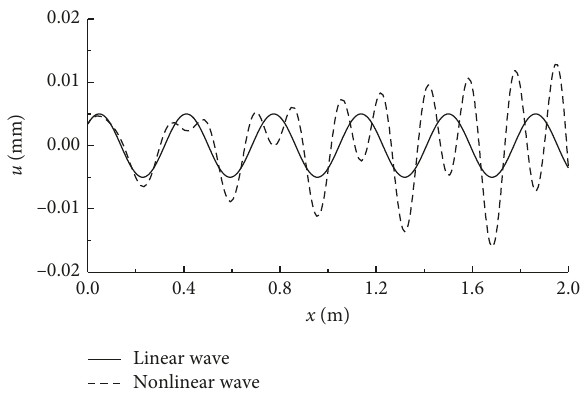
Figure 2: Transmission of the nonlinear wave that is calculated by Equation (6) and the linear wave in rock at t